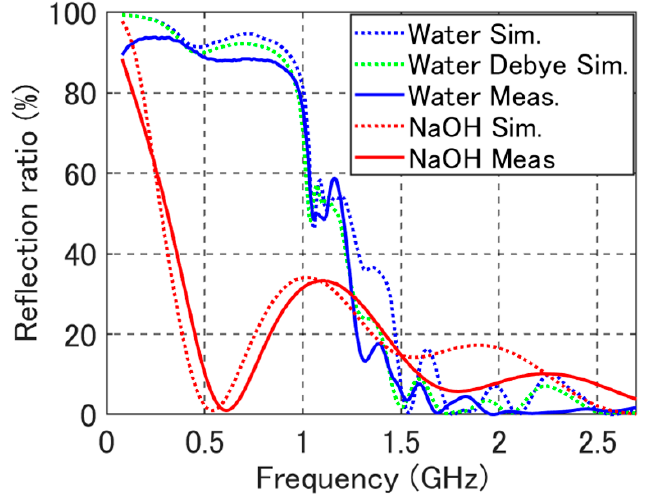
Figure 6. Simulated and measured results of the reflection ratios for the developed cylindrical applicator using liquid samples of water and a NaOH solution.